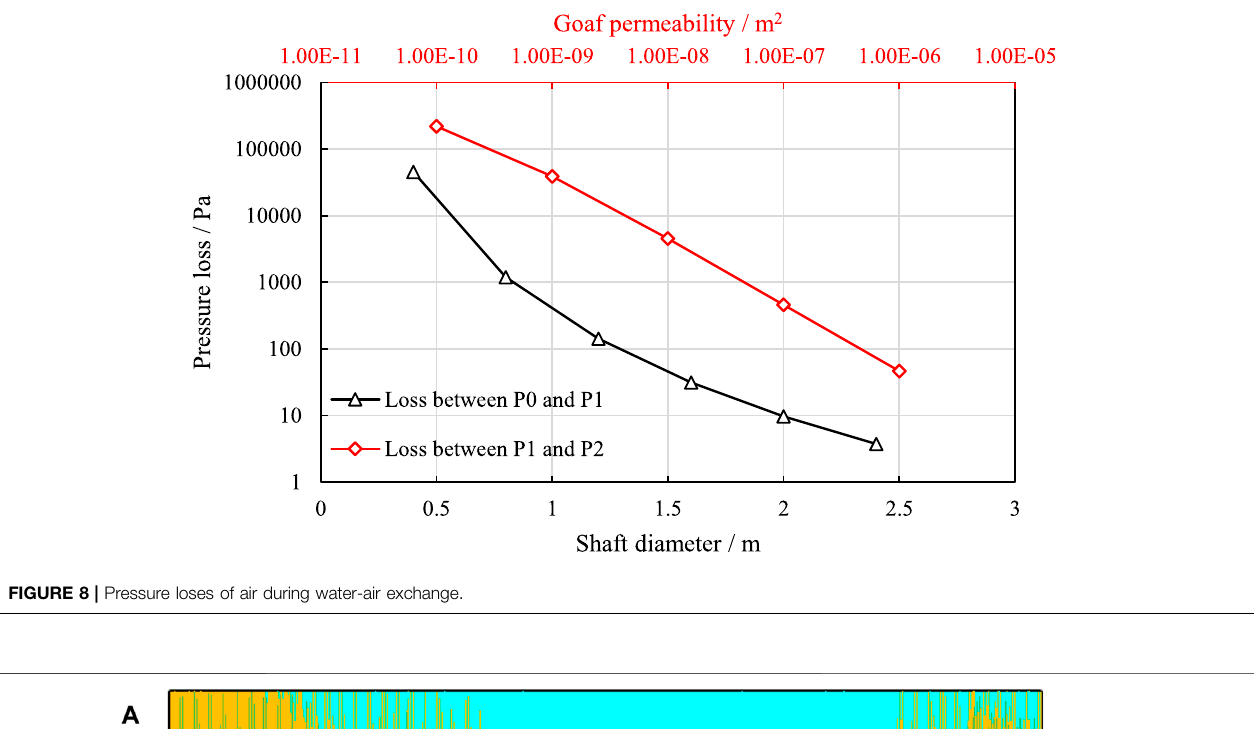
FIGURE 8 | Pressure loses of air during water-air exchange.